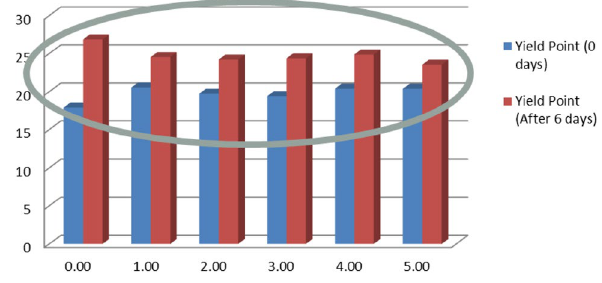
Fig. 19 Effect of NaCl, KCl and haematite on mud cake thickness of PHPA–bentonite mud